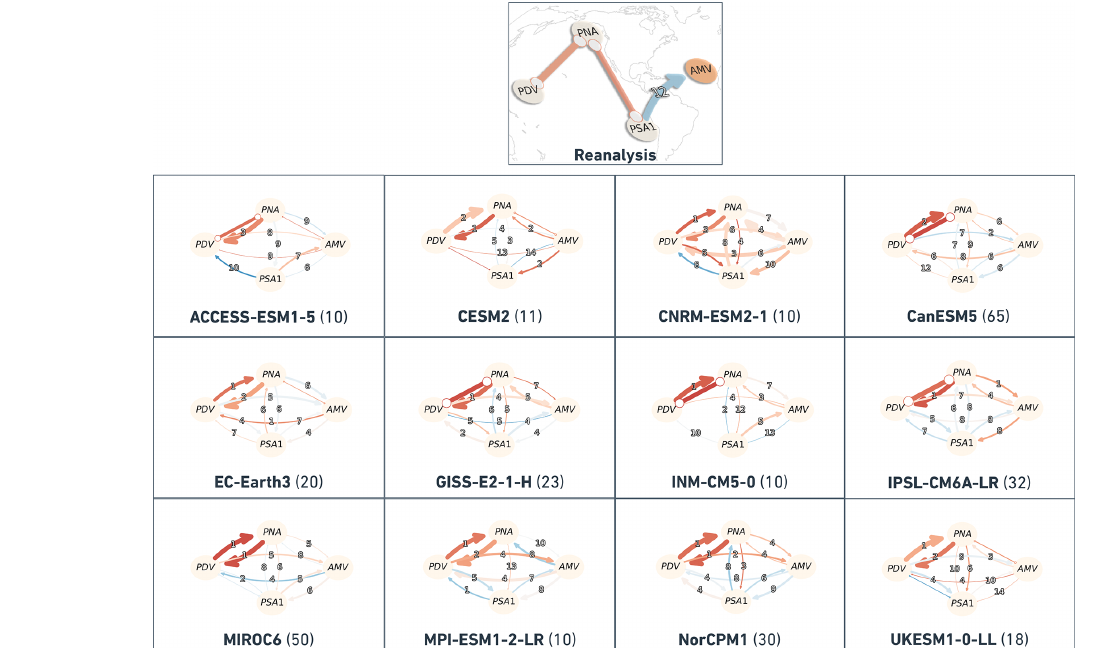
Figure A3. Similar to Fig. 7 but for the 12 CMIP6 models during the in-phase regime . Each panel has a label stating the model name and the number of ensemble members between parentheses. The auto-MCI values were not taken into